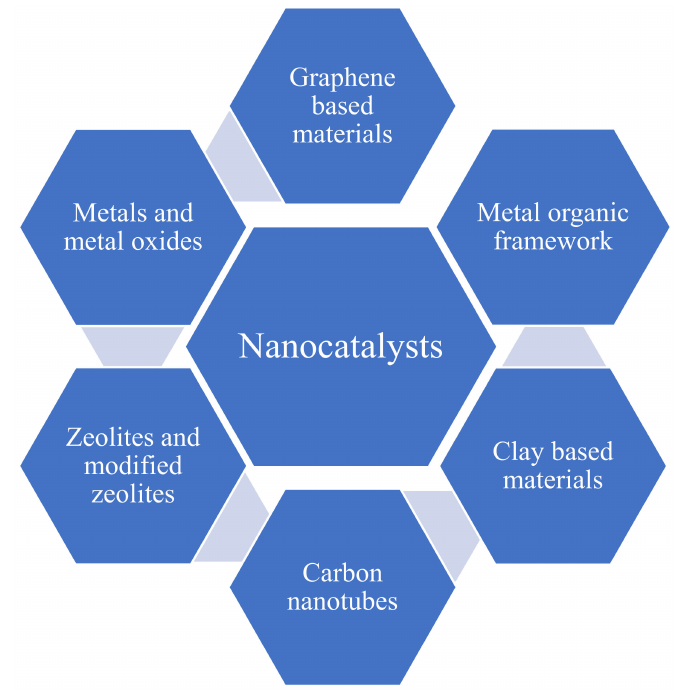
Figure 1. Various types of nanocatalysts used in